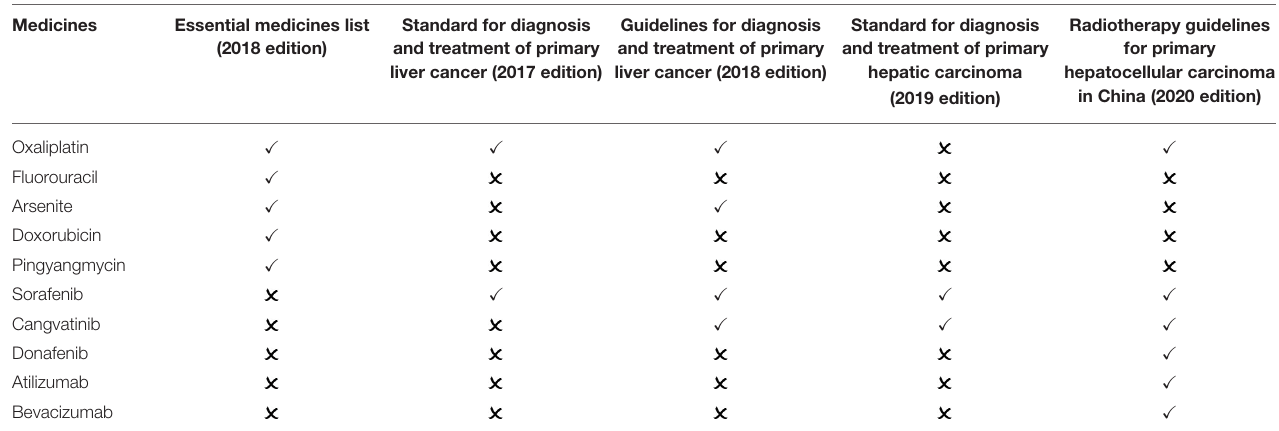
TABLE 1 | Medicines in the list and guidelines for the treatment of liver cancer.